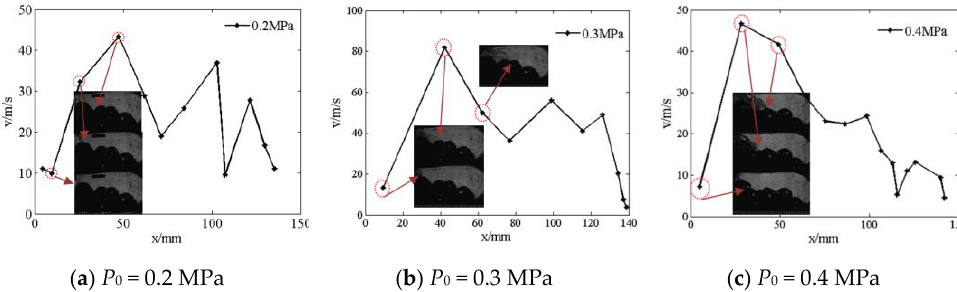
Figure 6. Flame tip velocity at initial pressures 0.2 MPa,0.3 MPa and 0.4 MPa.